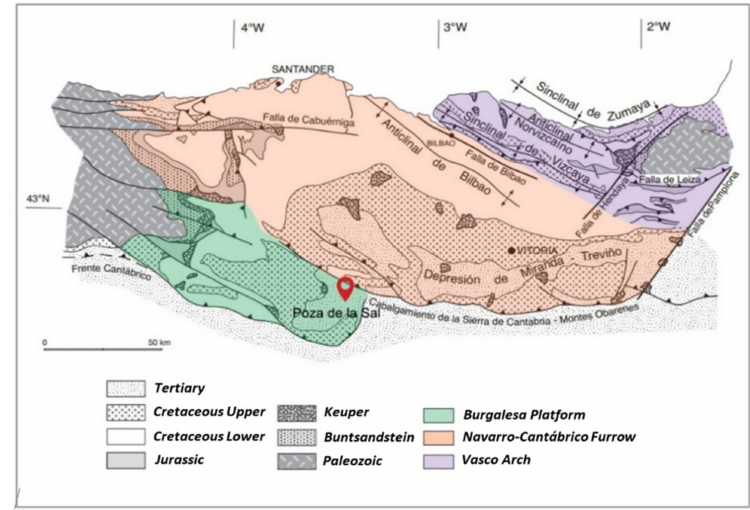
Figure 4. Geology of the Basque-Cantabrian Basin [16].